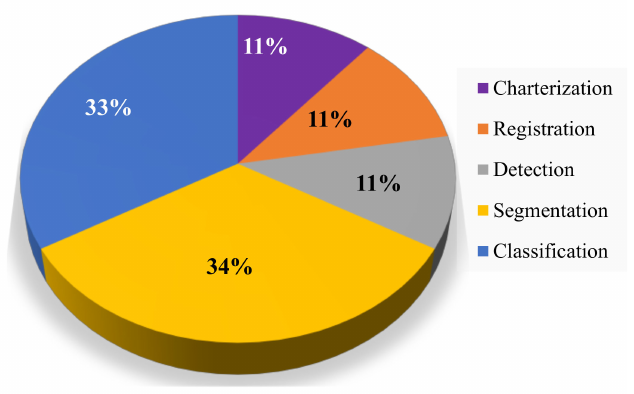
Figure 6. The deep learning application in a medical imaging